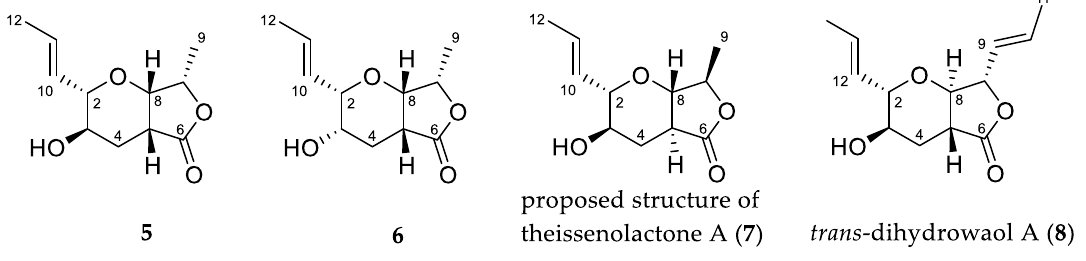
Figure 2. Structures of reported γ-lactones 5 – 8 .